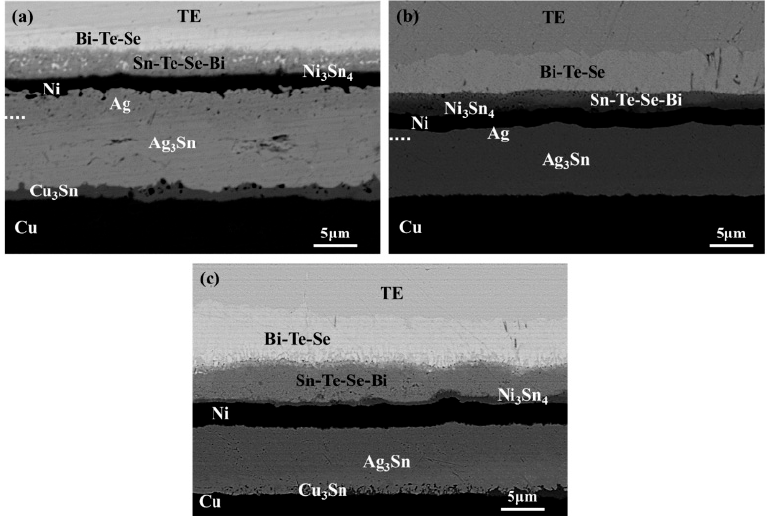
Figure 4. Morphology of intermetallic compounds formed after diffusion soldering between Bi 2 Te 2.55 Se 0.45 thermoelectric material and the Cu electrode with Sn interlayers at 300 °C for various times: ( a ) 5 min, ( b ) 10 min, ( c ) 30 min.